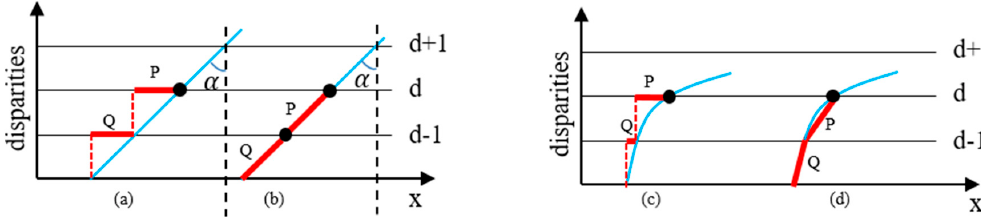
Figure 7. Disparity searching in 1D. Points of the blue surface are to be reconstructed. The disparity search path is shown by red bars. ( a ) Disparity estimation route of a plane with semi-global matching (SGM). ( b ) Ideal disparity estimation route of a plane. ( c ) Disparity estimation route of a curved surface with SGM. ( d ) Ideal disparity estimation route of a curved surface.